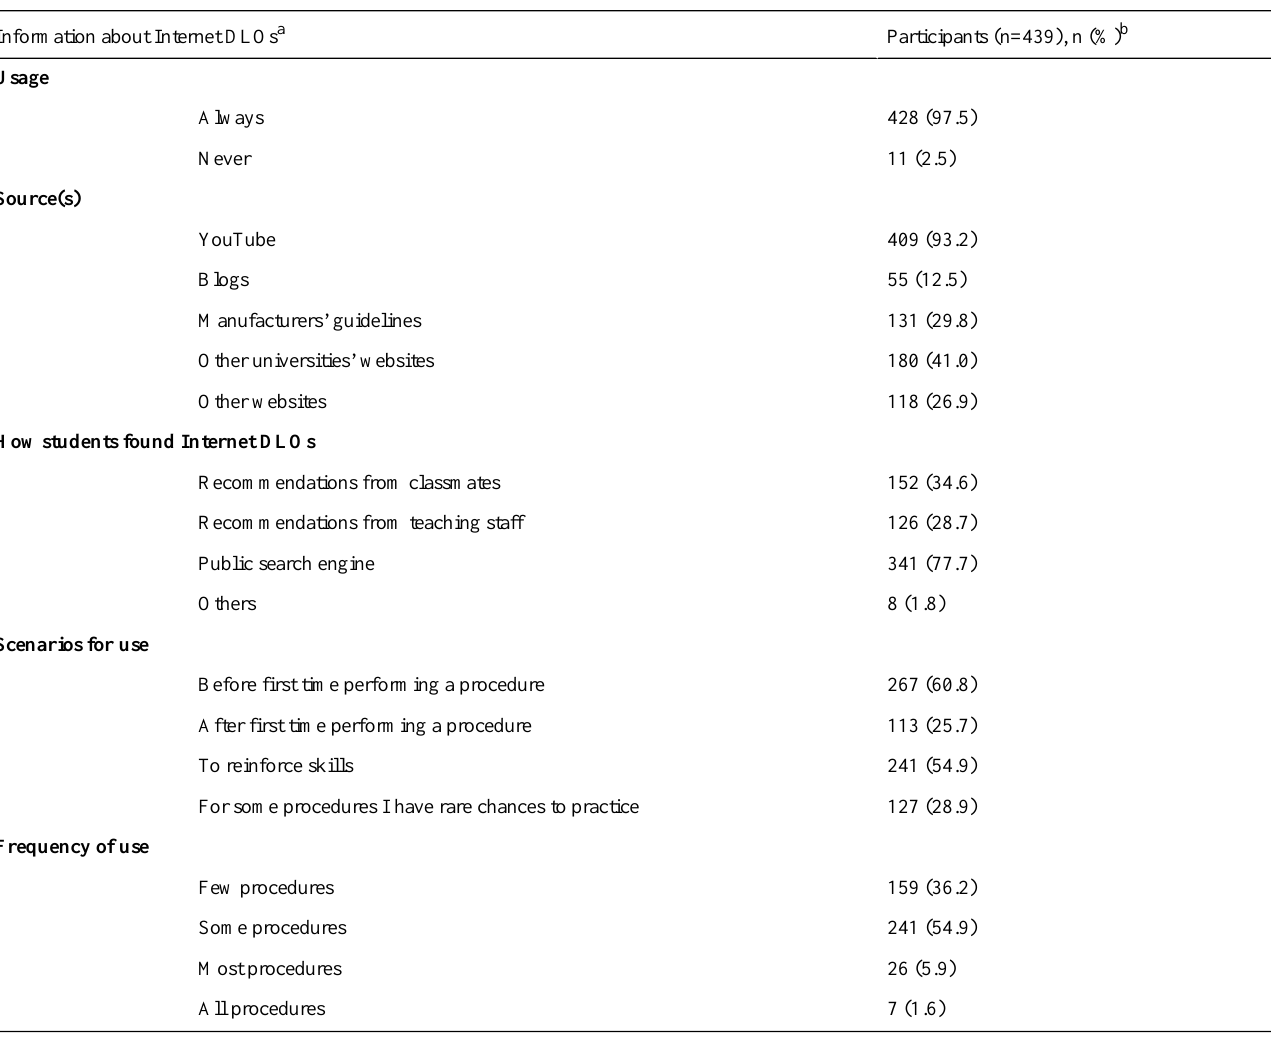
Table 1. Uses of, and access to, Internet digital learning